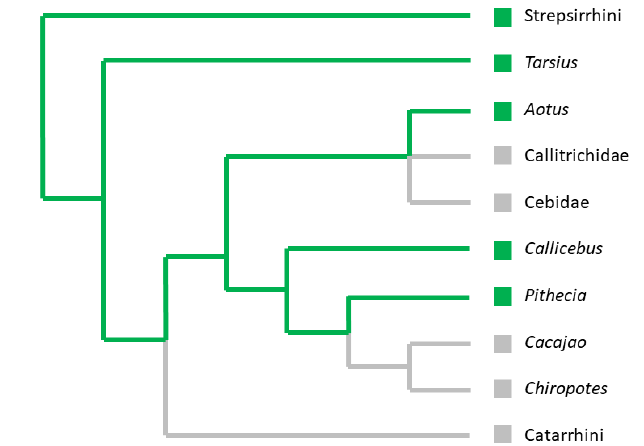
Figure 2. Simplified primate phylogeny showing the presence ( ) or absence ( ) of a grooming claw in different lineages. We used a polytomy for the clade conformed by Aotus , Callitrichidae and Cebidae, as the position of Aotus within this clade is contentious (Kay, 2015; Schrago and Seuánez,